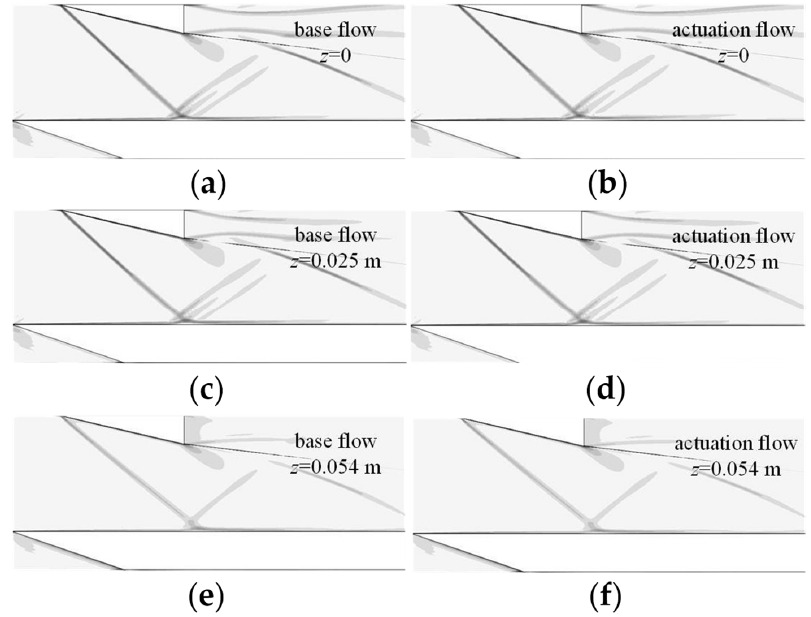
Figure 16. Numerical schlieren of three cross sections: ( a ) z = 0 base flow field; ( b ) z = 0 actuation flow field; ( c ) z = 0.025 m base flow field; ( d ) z = 0.025 m actuation flow field; ( e ) z = 0.054 m base flow field; ( f ) z = 0.054 m actuation field.